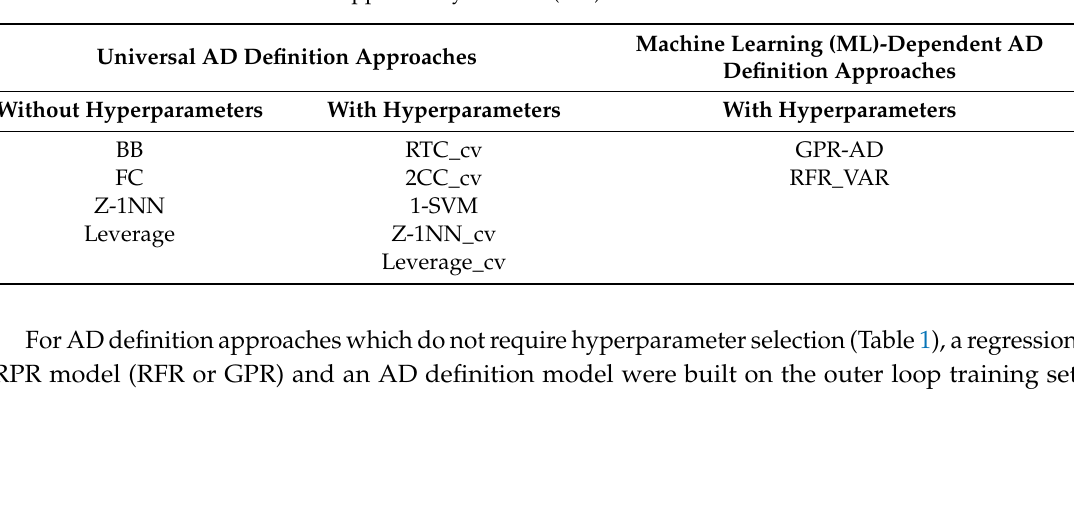
Table 1. Applicability domain (AD) definition